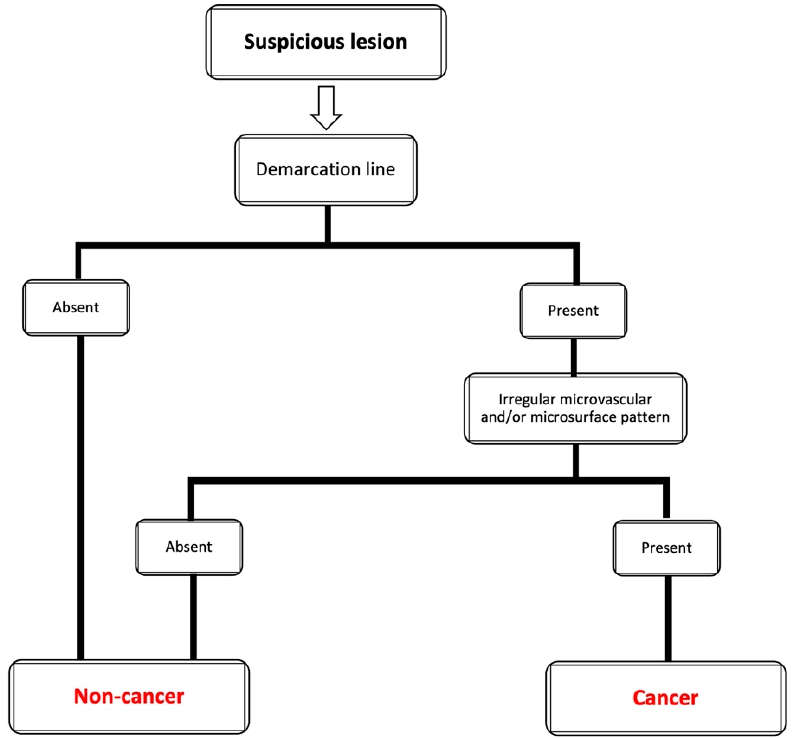
Figure 2. Magnifying endoscopy simple diagnostic algorithm for early gastric cancer (MESDA-G) [22].